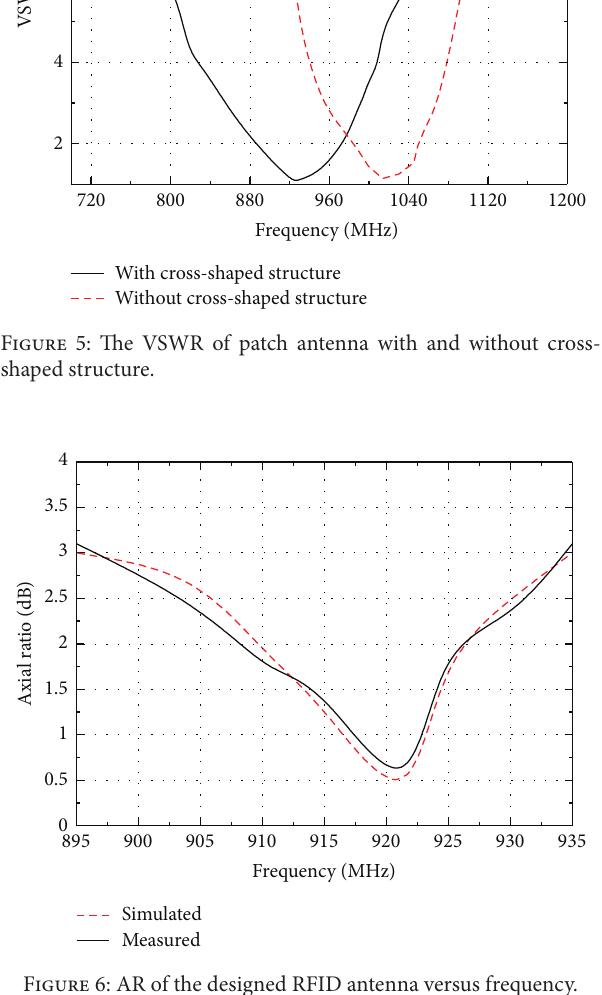
Figure 4: The measured Smith chart of the proposed CP RFID antenna.